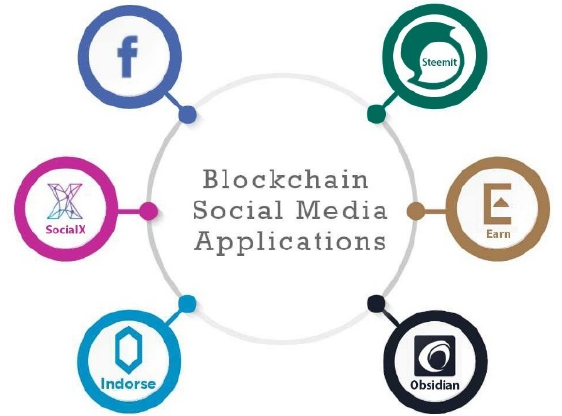
Figure 2. Blockchain in social media.